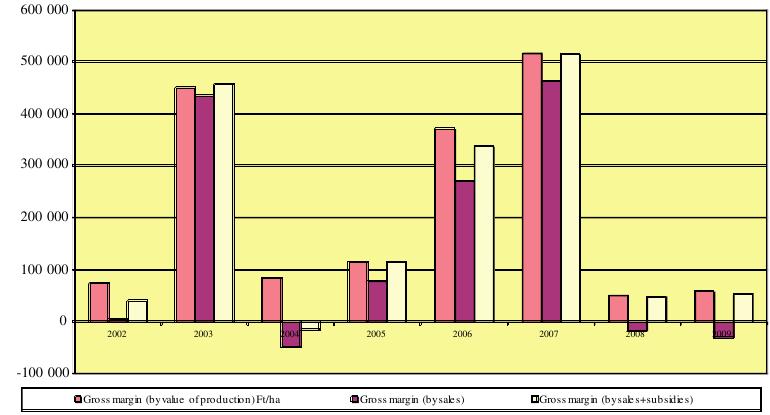
Figure 2. The gross margin pattern for sour cherry